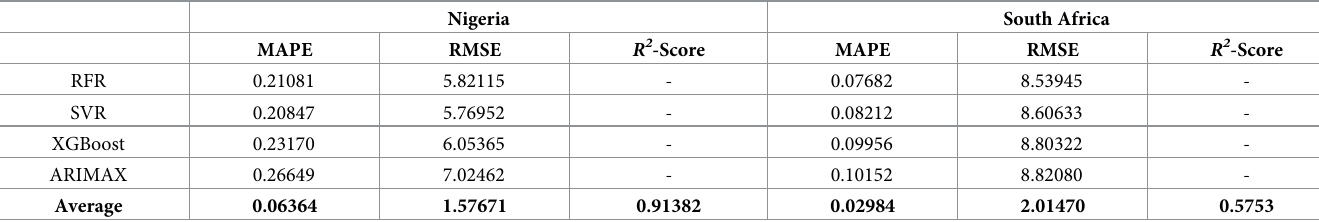
Table 3. Method evaluation. Accuracy of different machine learning algorithms used for predicting the unemployment rate.